Question: Briefly state, in one sentence, what is plotted here.
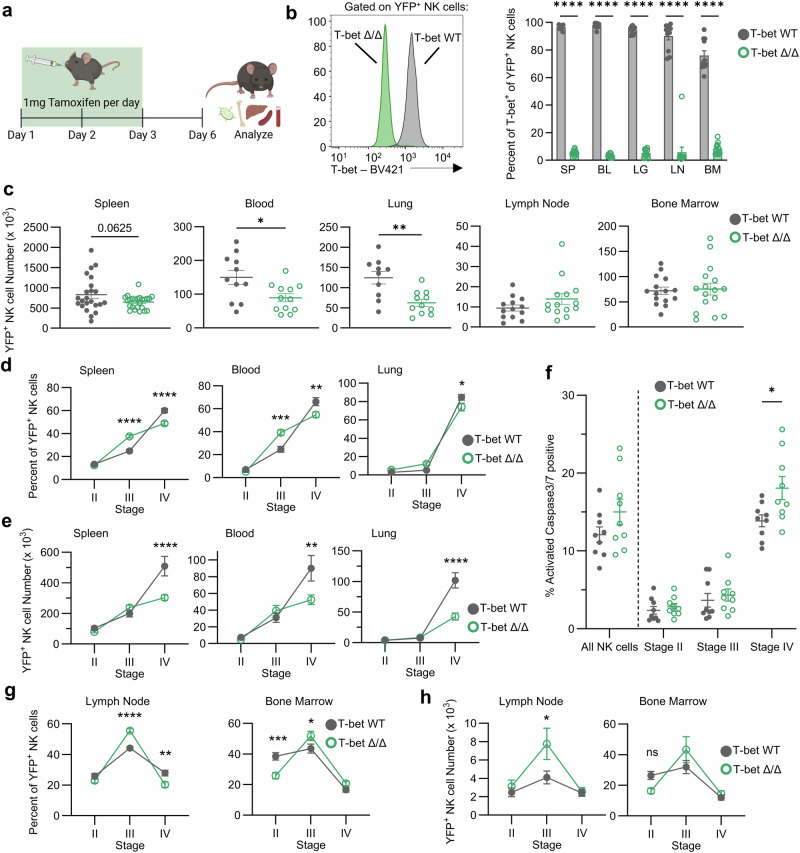
Answer: Induced T-bet deletion results in alteration of NK cell maturation. a Ncr1 -iCreER T2 x Rosa26- YFP LSL x Tbx21 fl/fl (T-bet Δ/Δ) mice and Ncr1-iCreER T2 x Rosa26-YFP LSL x Tbx21 WT/WT (T-bet WT) mice were treated with 1 mg tamoxifen by oral gavage for 3 days (Day 1-3), then on Day 6, mice were analyzed. YFP + percentage of NK cells (CD3 - NK1.1 + NKp46 + ) in indicated organs: spleen (SP), blood (BL – per mL), lung (LG), lymph nodes (LN – inguinal LNs), bone marrow (BM – per femur). Created in BioRender. Fehniger, T. (2026) https://biorender.com/phgwwq4 . b Representative histogram of T-bet expression, left. T-bet + percentage within YFP + NK cells, right ( n = 10-12 per group). c YFP + NK cell numbers in the 5 different tissues indicated ( n = 10-24 per group). d, e Summary data of percentage ( n = 10-24 per group) and absolute numbers of YFP + NK cells ( n = 10-24 per group) within each indicated maturation stage. f assessment of activated Caspase 3/7 in YFP + splenic NK cells ( n = 9 per group). g, h Percentage ( n = 13-16 per group) and absolute numbers ( n = 13-16 per group) of YFP + NK cells within each indicated maturation stage in the lymph node and bone marrow. Summary data are shown as mean ± SEM; Statistical significance was determined by multiple unpaired t-tests with Holm-Šídák method in b for adjusted p-values, two-sided unpaired t-tests in c , and by 2-way ANOVA with Šídák’s multiple comparisons test in ( d–h ) for adjusted p-values. 3-7 independent experiments. * = p < 0.05, ** = p < 0.01, *** = p < 0.001, **** = p < 0.0001. Exact p-values are provided in the Source Data file.